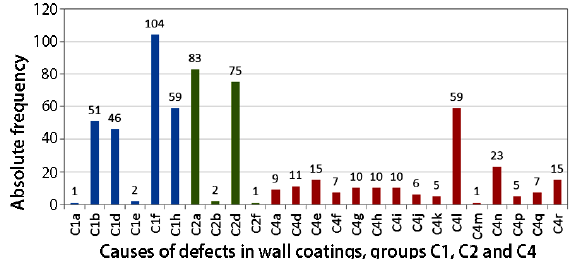
Fig. 26. Absolute frequency of the specific causes of anomalies in wall coatings (10) belonging to general groups C1, C2 and